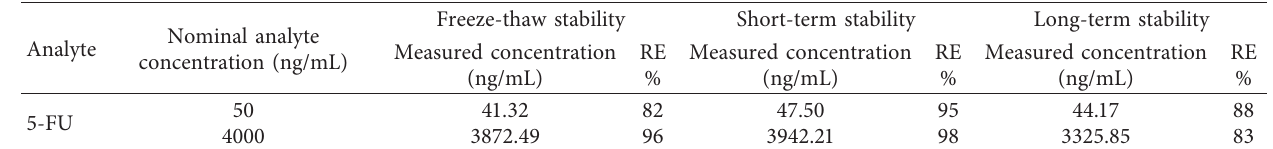
Table 5: The stability of analytes in different conditions ( n �